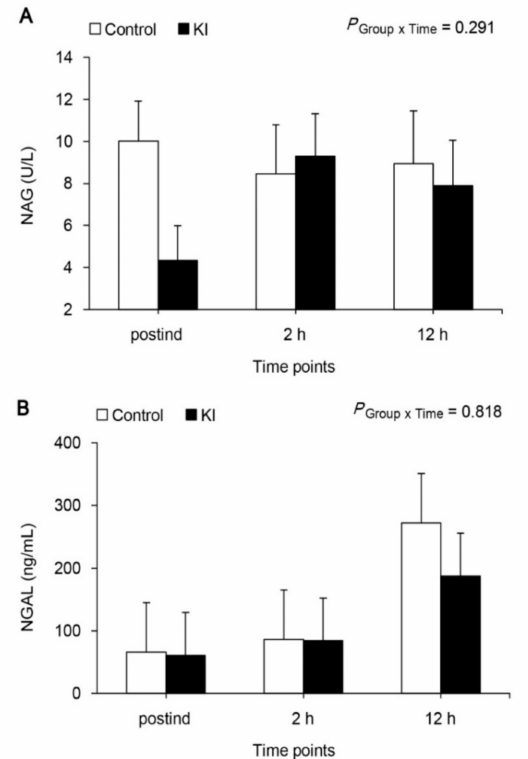
Figure 4. Urinary NAG ( A ) and serum NGAL ( B ) NAG, N-acetyl-1- β -D-glucosaminidase; NGAL, neutrophil gelatinase-associated lipocalin; postind, 10 min after anesthesia induction; 2 and 12 h, 2 and 12 h after renal artery